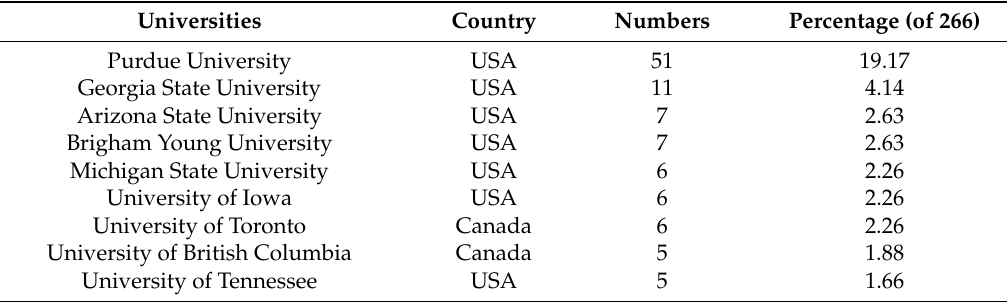
Table 5. The affiliations of the scholars who published SLW publications (five or